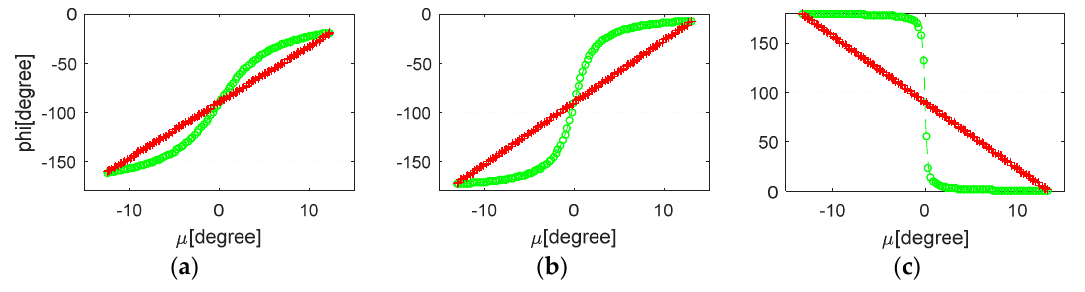
Figure 4. The yaw angle of G06 (IIF) during shadow crossing for different sun angles: ( a ) beta = 4.19°; ( b ) beta = 1.58°; and ( c ) beta = − 0.17°. The nominal yaw angle is shown in green, while the modeled one is in red.